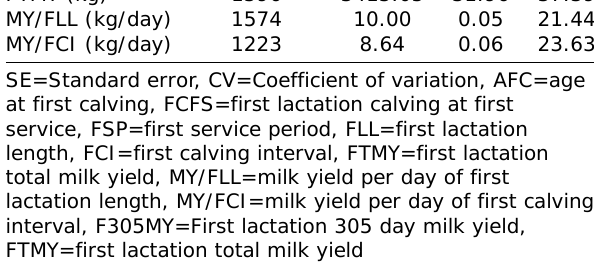
Table-2: Range of EBVs estimated by sire and animal model for first lactation production and fertility traits. Traits